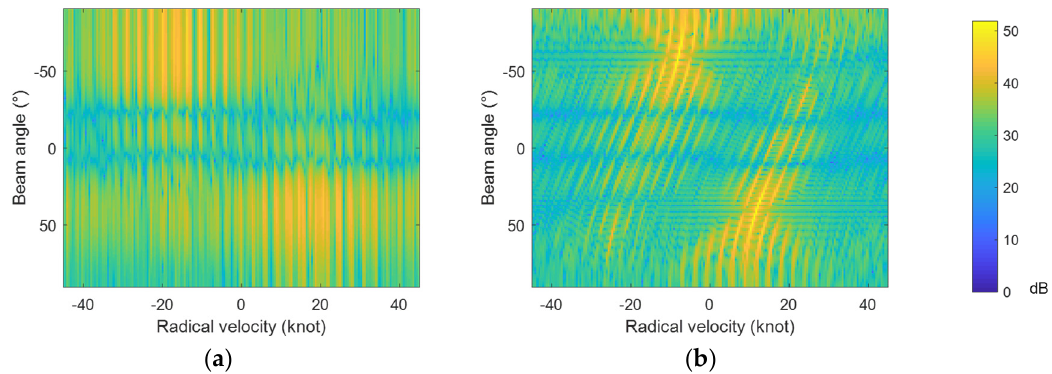
Figure 17. Space–time two-dimensional spectrum before and after motion compensation when ship velocity is 10 knots; the swing period P = 20 s and the swing amplitude is 5°: ( a ) results before motion compensation, ( b ) results after motion compensation.